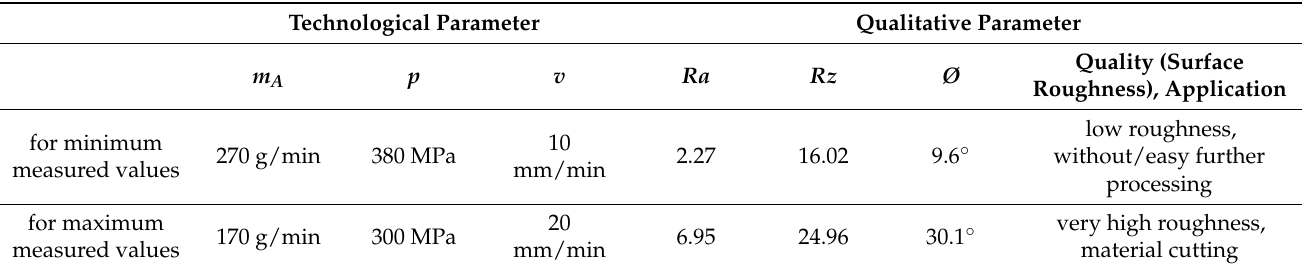
Table 6. Recommended values of technological parameters for achieving minimum and maximum experimentally measured values of parameters Ra , Rz and Ø .